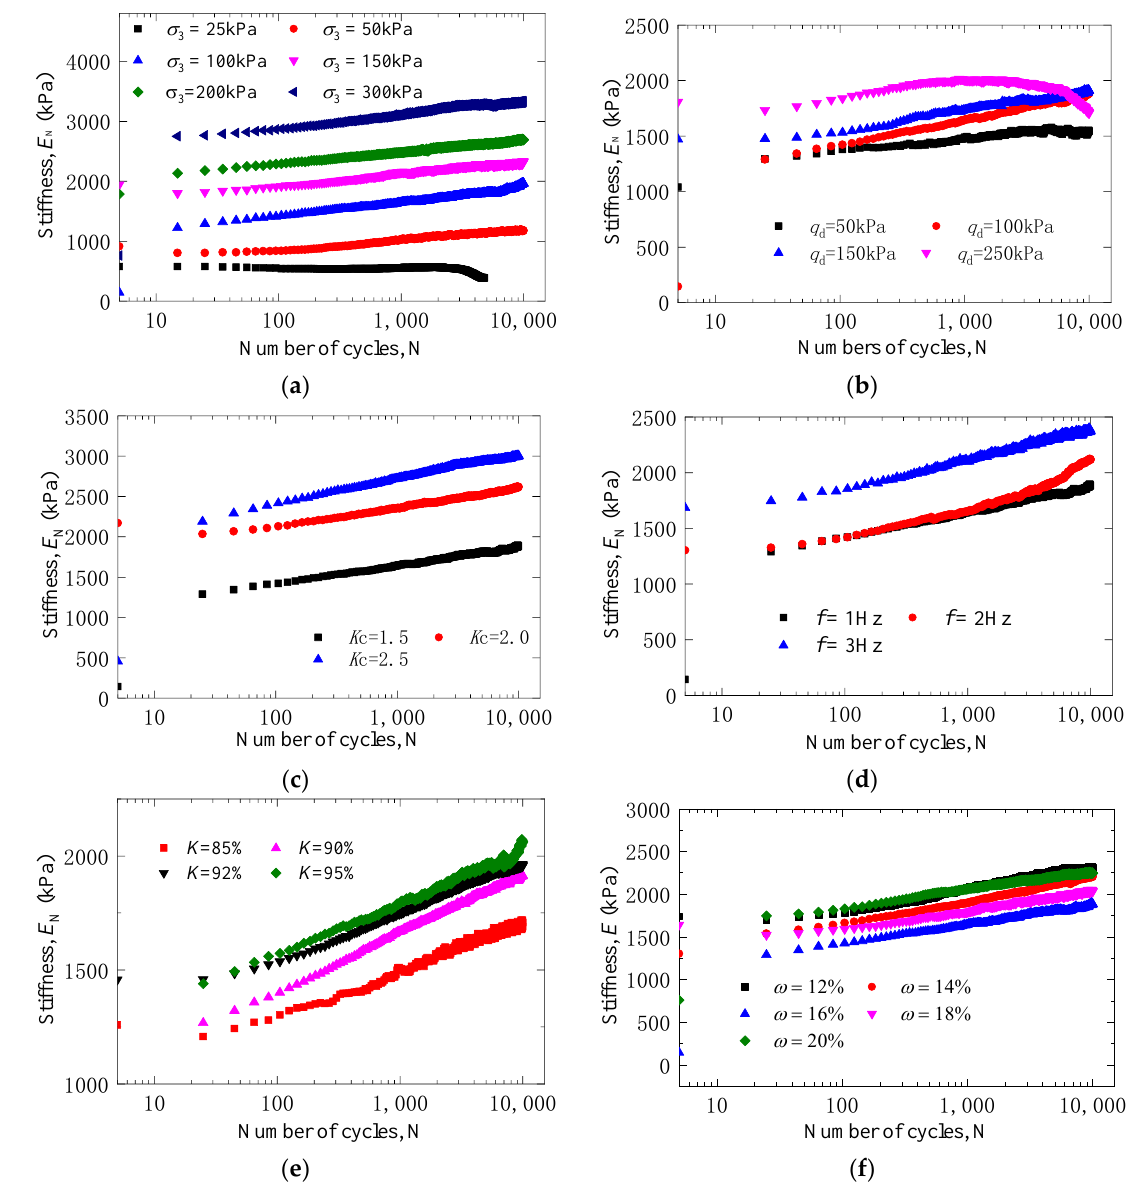
Figure 5. Stiffness under different testing conditions. ( a ) Stiffness versus number of cyclic loading under different confining pressures. ( b ) Stiffness versus number of cyclic loading under different loading amplitudes. ( c ) Stiffness versus number of cyclic loading under different K c . ( d ) Stiffness versus number of cyclic loading under different loading frequencies. ( e ) Stiffness versus number of cyclic loading under different relative densities, K . ( f ) Stiffness versus number of cyclic loading under different moisture content.